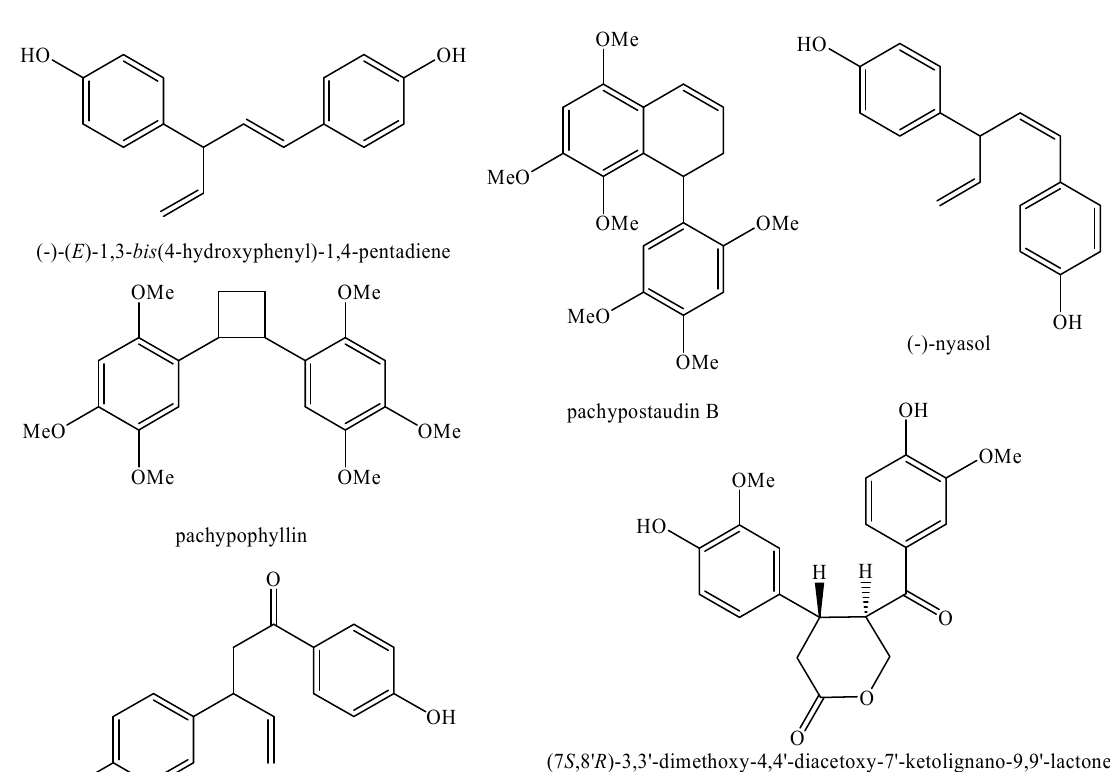
Figure 16. Isolated nor -lignans in the plant kingdom—part 15.